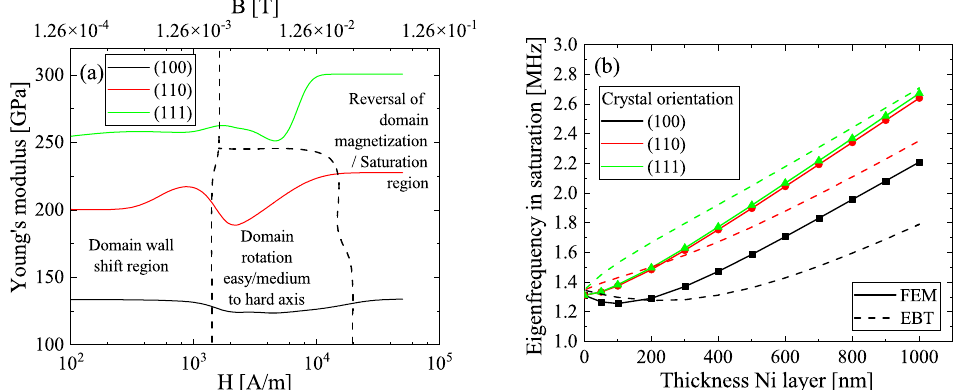
Figure 2. ( a ) Computed magnetic-field-dependent curves of Young’s modulus for the three principal axes. ( b ) Eigenfrequencies of the simulated cantilevers in magnetic saturation as a function of the crystalline orientation of the Nickel layer and its